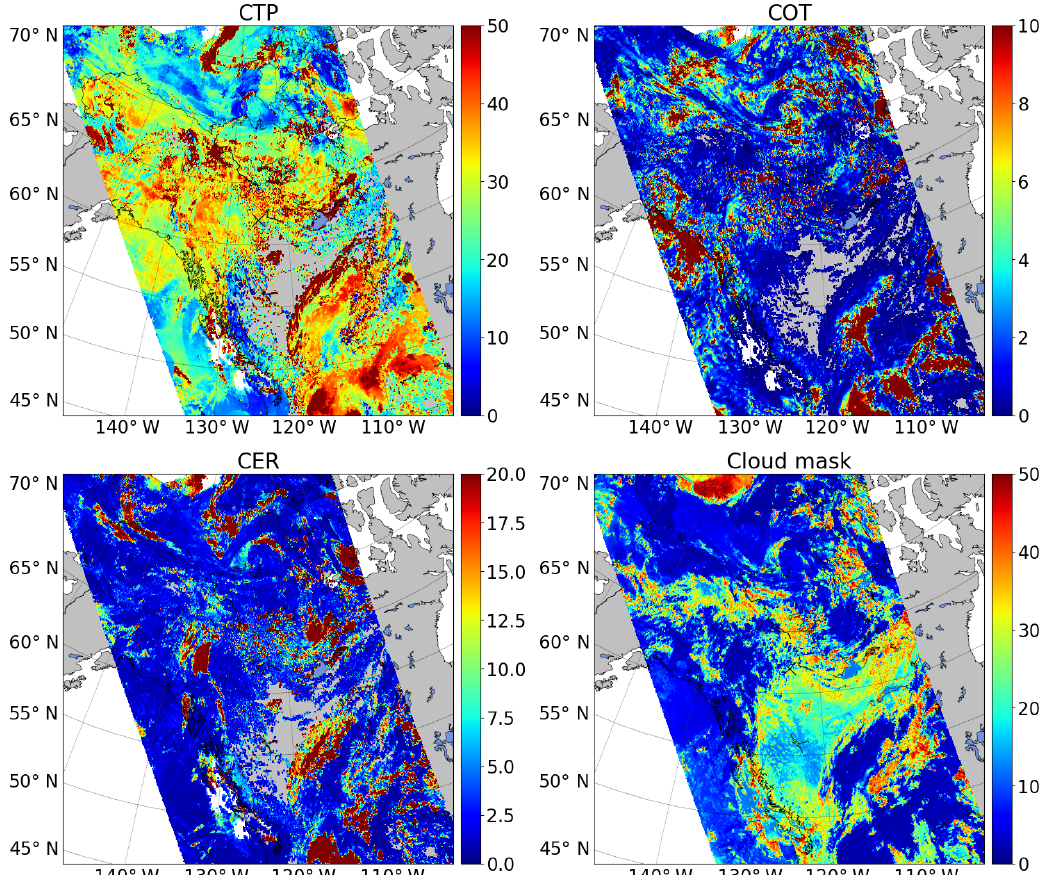
Figure 7. Absolute uncertainties of MODIS AQUA retrieval data for study area NA2 and CTP [hPa], COT, CER [µm], and Cloud mask [%].